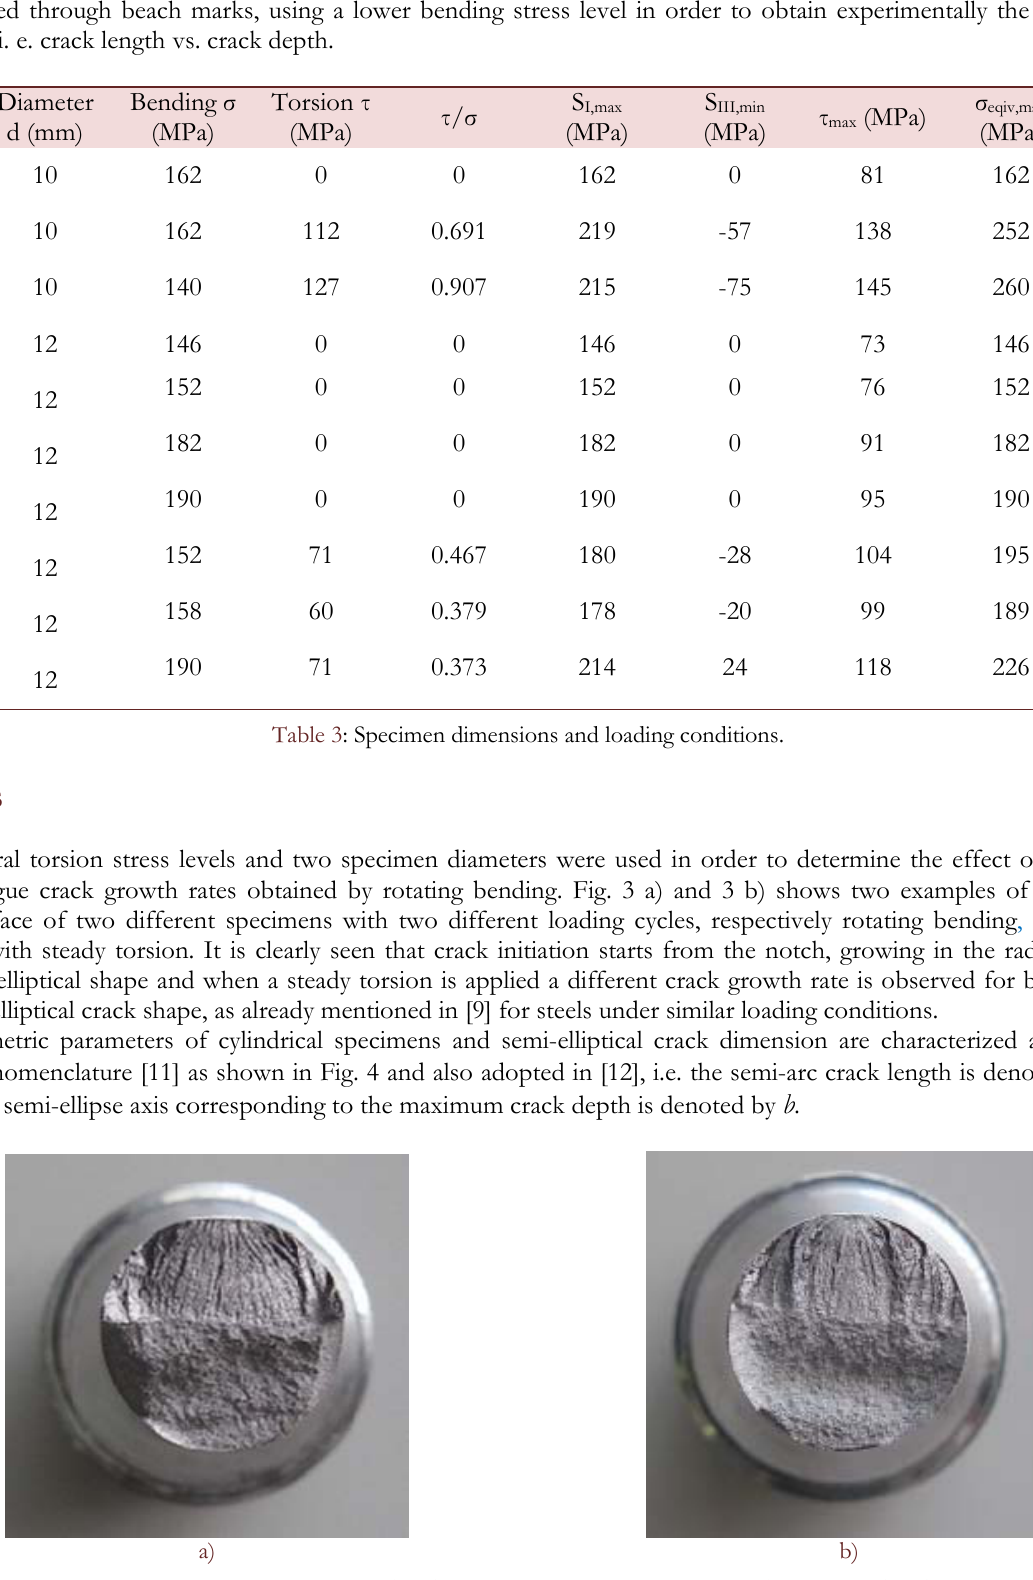
Figure 3: Fracture surfaces for: a) pure rotating bending (symmetrical crack growth); b) rotating bending with steady torsion (nonsymmetrical crack